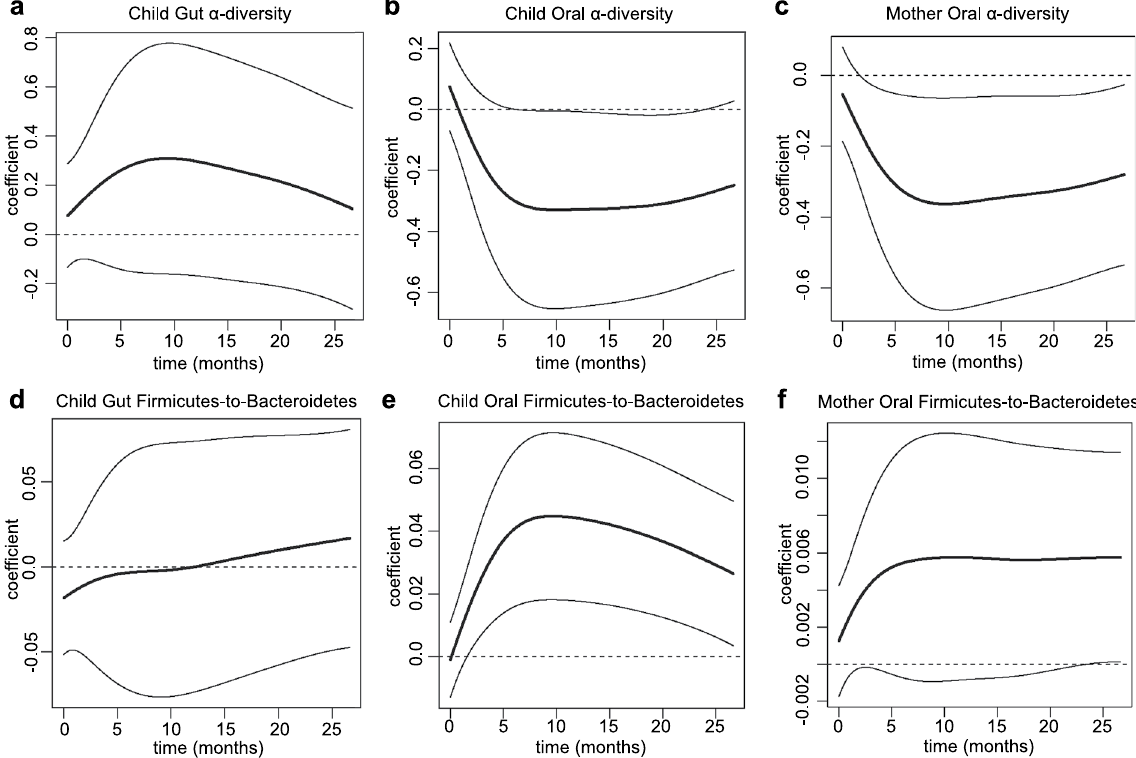
Figure 2. Oral and Gut microbiota’s relationships with growth curves. Estimated regression coefficient curves expressing the associations of growth curves with ( a ) children’s gut α -diversity, ( b ) children’s oral α -diversity, ( c ) mothers’ oral α -diversity, ( d ) children’s gut Firmicutes-to-Bacteroidetes ratio, ( e ) children’s oral Firmicutes- to-Bacteroidetes ratio and ( f ) mothers’ oral Firmicutes-to-Bacteroidetes ratio. Each curve is accompanied by a point-wise confidence band 92